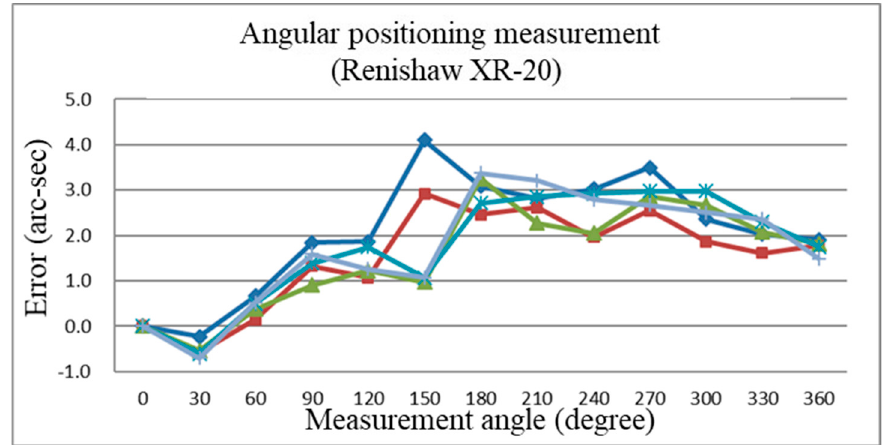
Figure 22. The angular positioning measurement (Renishaw XR20).